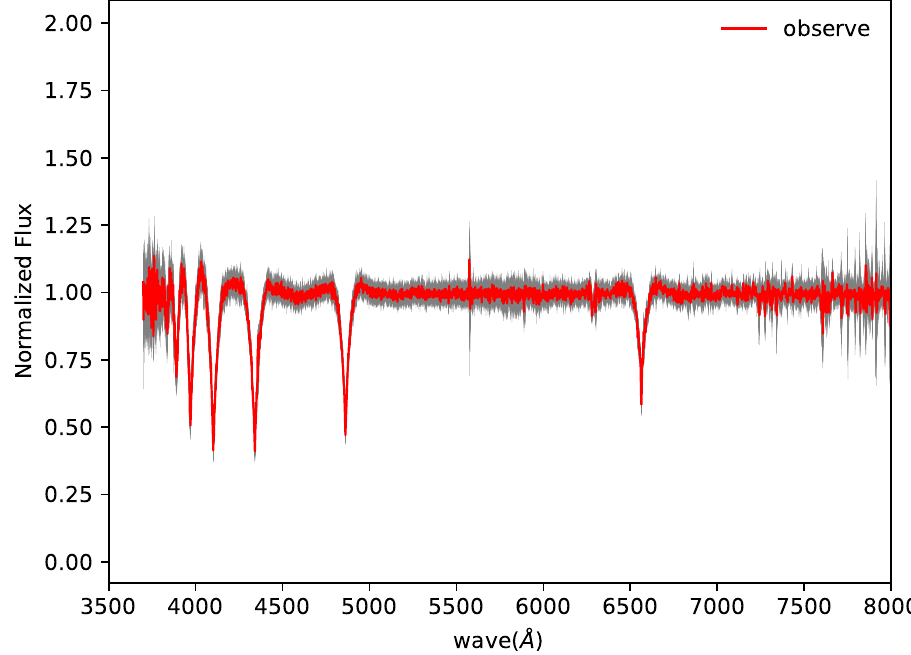
Figure 2. The normalized spectra of the generated 100 simulated spectra (gray line) and the normal- ized spectra of the observed spectra (red line).